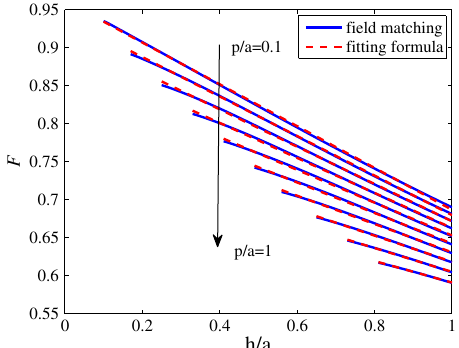
FIG. 15. Amplitude factor F from field matching solution (blue solid line) and corresponding best fit to Eq. (A5) (red dashed line).